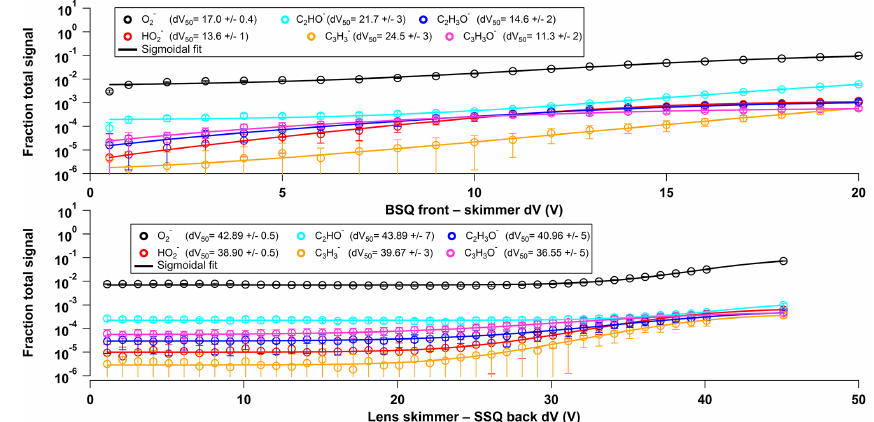
Figure 8. Voltage scanning experiments for a variety of potential fragment ions. Top: component relation 5. Bottom: component relation 3.